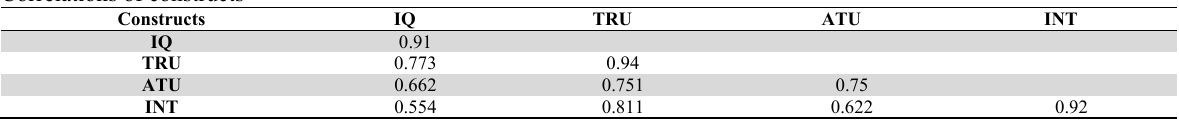
Correlations of constructs Constructs